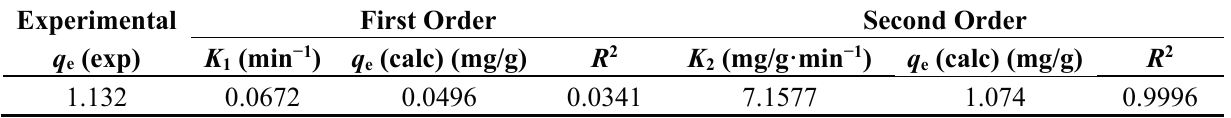
Figure 9. Kinetic model: ( a ) pseudo-first order kinetic model and ( b ) pseudo-second order kinetic model for MIP beads. Table 2. The first and second order kinetic constants for the MIP